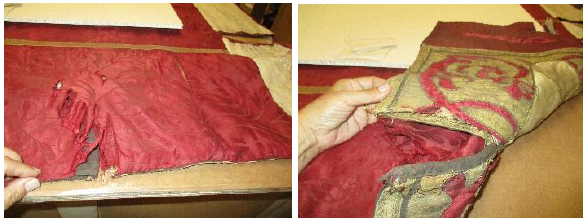
Figure 17 - Tear consolidation on Sta Justa banner.